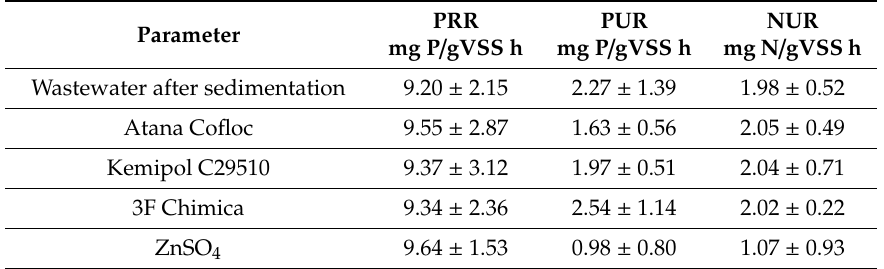
Table 2. Average nitrogen and phosphorus removal rates obtained using activated sludge samples from analyzed WWTPs and supernatant after 2-h sedimentation without and with addition of